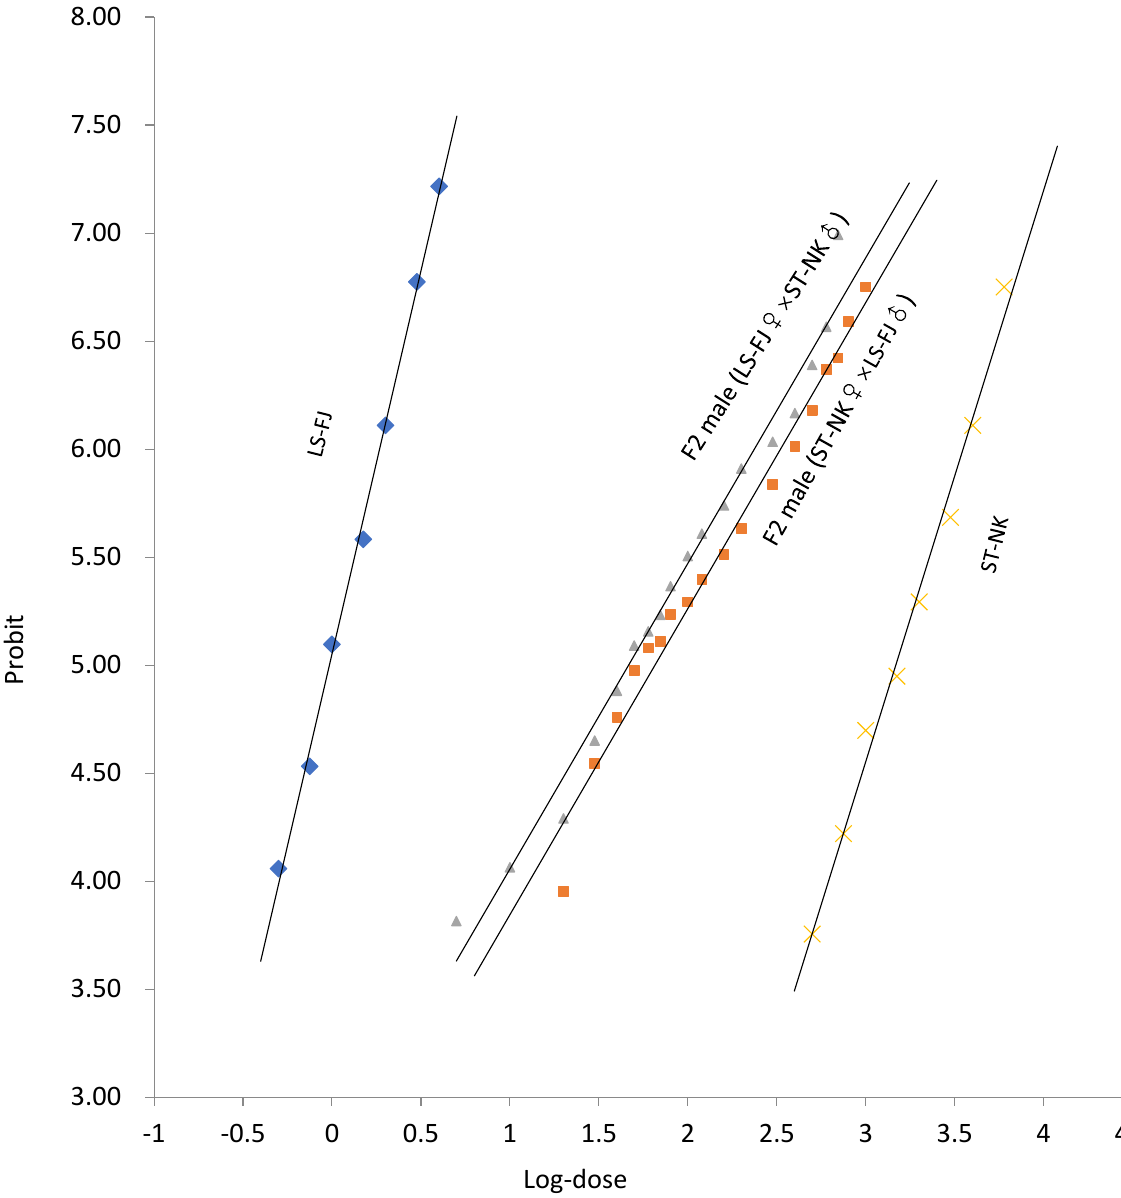
Figure 5. Spirotetramat concentration-mortality curves for parental males and F2 males derived from virgin F1 females.